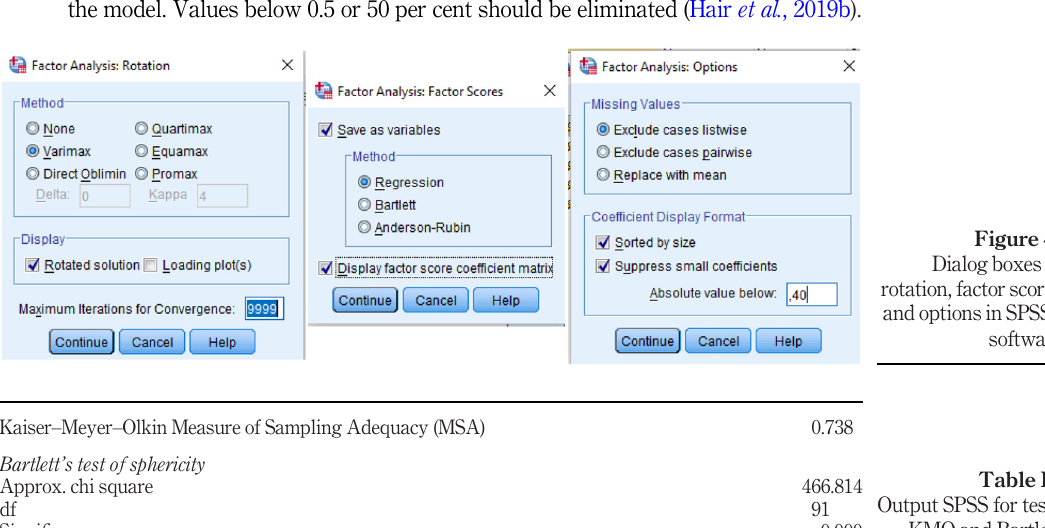
Table II. Output SPSS for